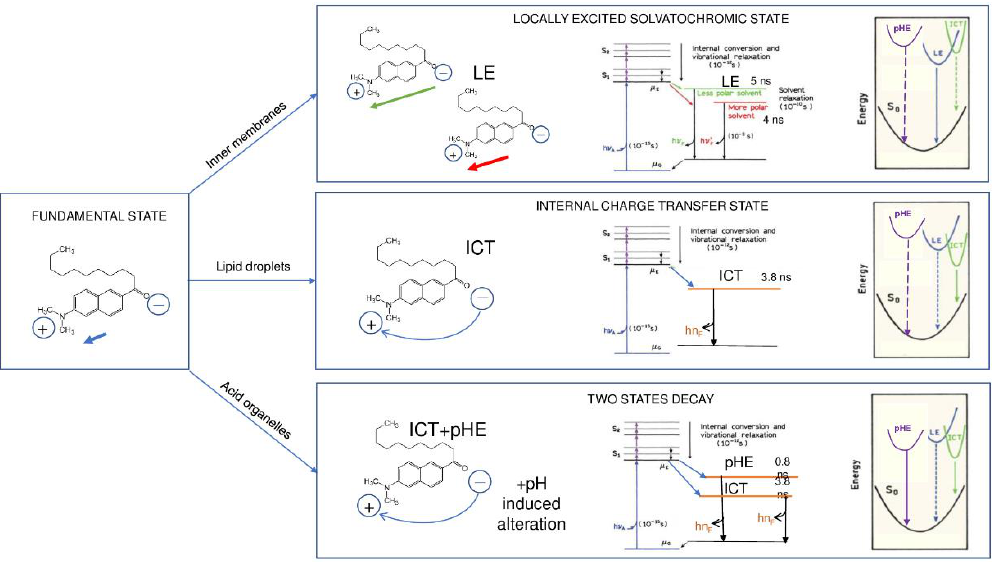
Figure 7. Photochemistry of dimethylaminonaphtalene-functionalized derivatives of fatty acids. The naphthalene functionalized FA derivatives present a locally excited, solvatochromic state coming from the probe localized on plasma membranes and inner membranes, an internal charge transfer (ICT) state coming from the probe localized in lipid droplets, and a two-state emission from ICT pHE (pH-activated emission state) coming from the probe localized in lysosomes. In highly nonpolar environment of LD, where the alignment of solvent dipoles is prevented, the ICT state becomes the lowest energy state, with complete charge transfer from the amino-group to the carbonyl group. In low pH environments of lysosomes, low lifetime photons come from an energetically favored state at low pH, called pHE, which emits along with ICT.